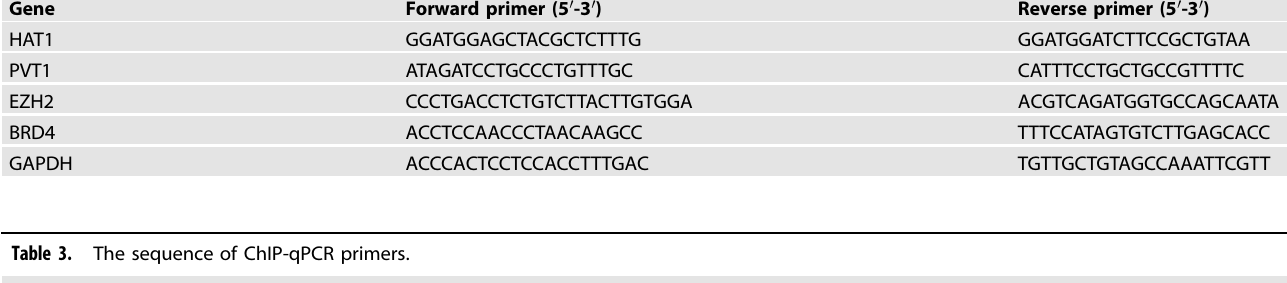
Table 2. The sequences of RT-qPCR primers.